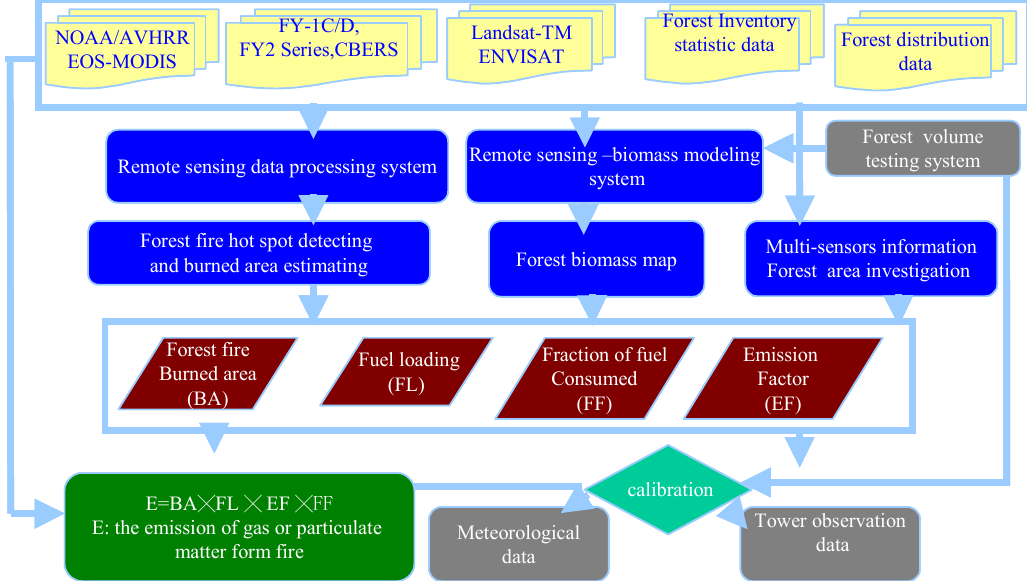
Figure 6. Forest fire emissions estimation system in